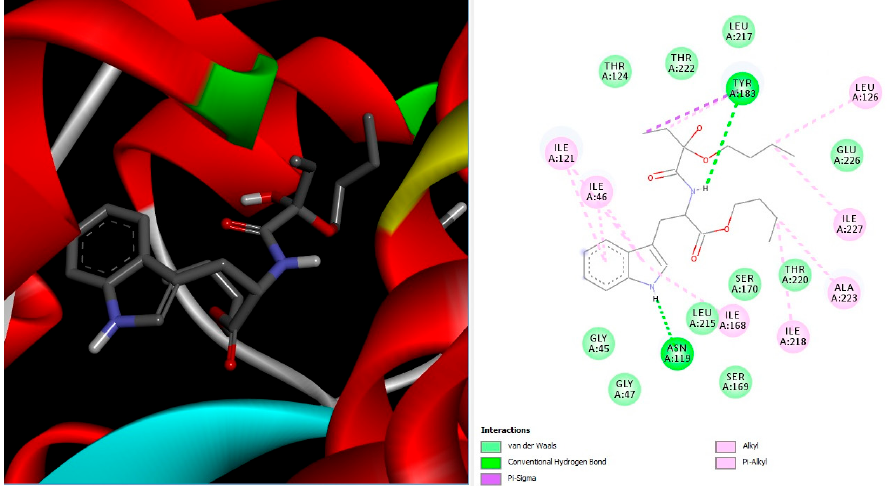
Figure 3. The 2D and 3D diagrams of the best-fit molecule 8 showing ligand interaction with different amino acid residues of the protein 11 β -HSD1 in the active site.